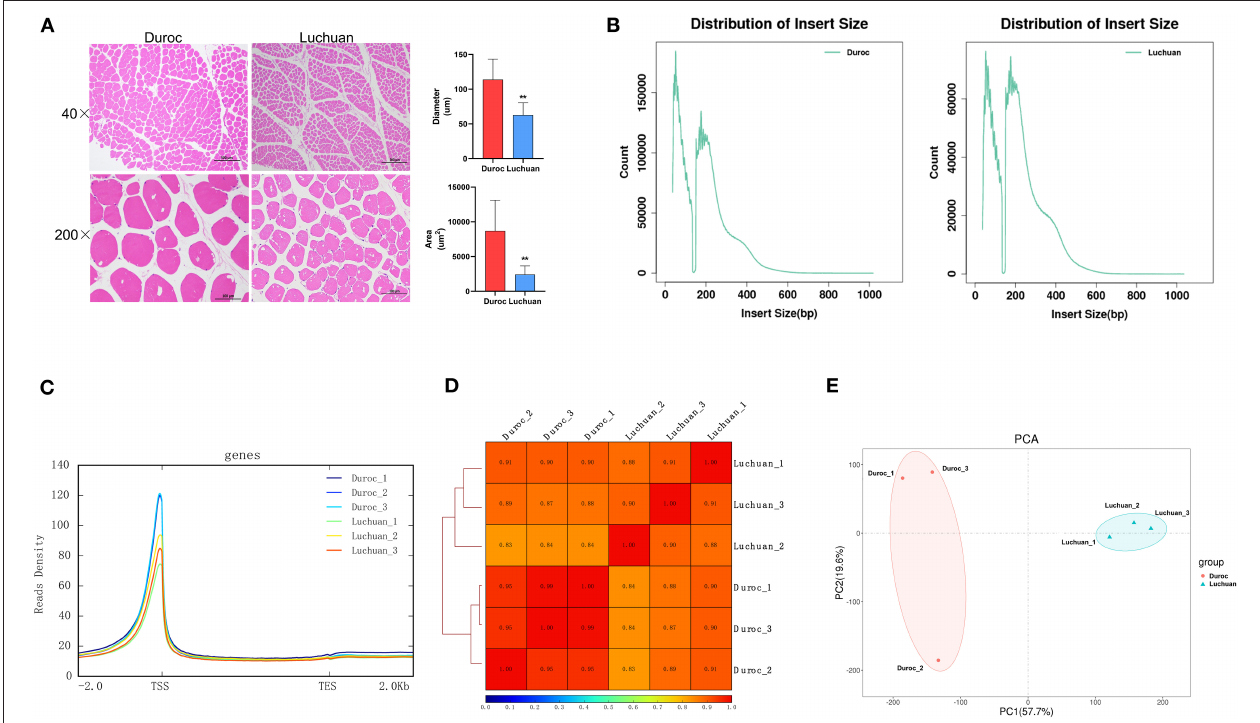
FIGURE 1 | Phenotype and ATAC-seq quality control. (A) Muscle tissue sections at 40 × and 200 × magnification. Quantification of the diameter and area of muscle fibers. The data are expressed as mean ± SD. ** P < 0.01. (B) Distribution of insert size. (C) Enrichment of ATAC-seq signals around the TSS. The x -axis represents the normalized gene or peak length, and the y -axis represents the read enrichment. The larger the value, the higher the enrichment. TSS, transcription start site; TES, transcription end site. − 2.0 represents 2kb upstream of the TSS, and 2.0 represents 2kb downstream of the TES. (D) The Pearson’s correlation results shown by a heat map scatterplot. (E) Principal component analysis (PCA).